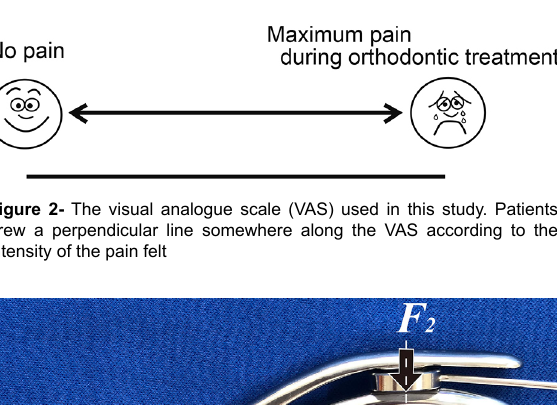
Figure 1- Allocation of the teeth. Arrows indicate the order of bracket removal